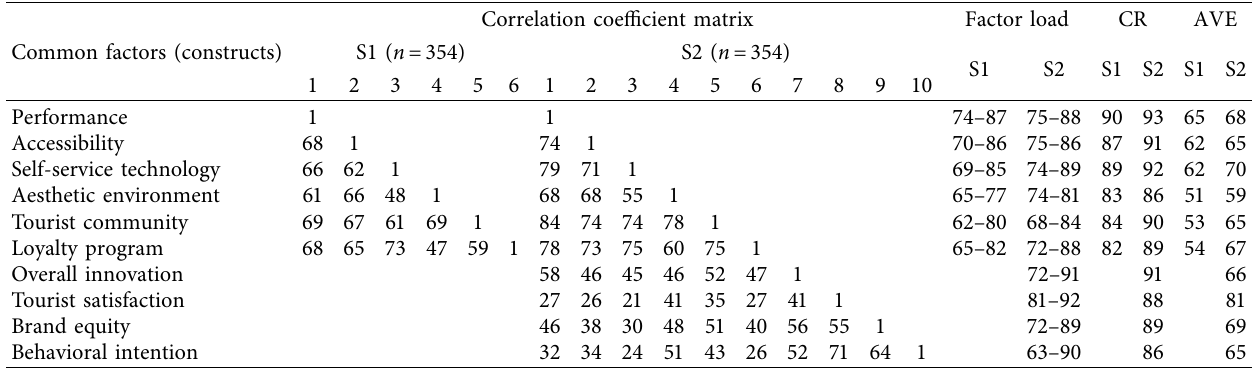
Table 1: Exploratory and confirmatory factor analysis